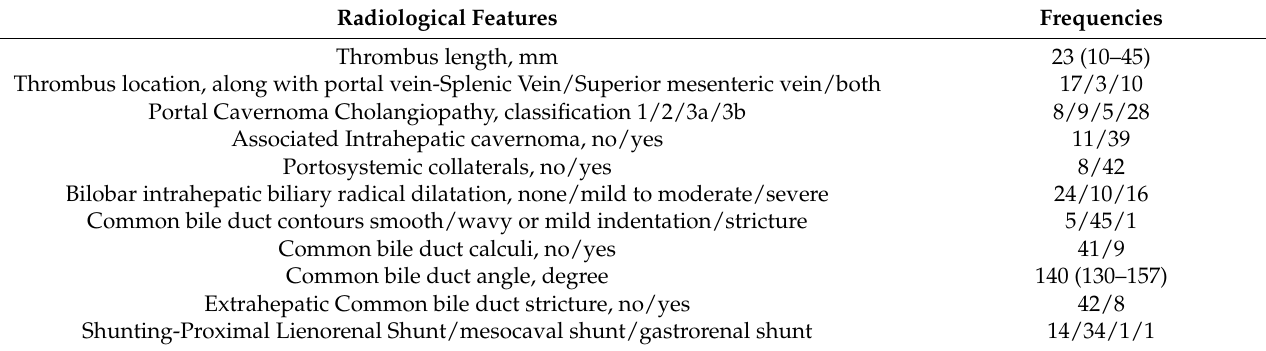
Table 2. Radiological features in cases of portal cavernoma